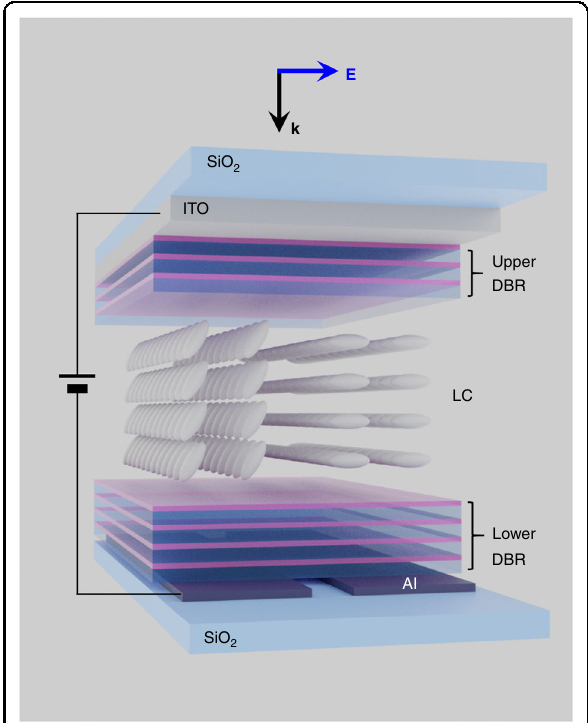
Fig. 1 Schematic view of the Fabry – Pérot cavity. It is composed of the LC as a refractive-index changing material sandwiched between the upper and lower distributed Bragg re fl ectors, allowing for the reduced cell gap and the corresponding small pixel size for the wide fi eld of view. The higher-order mode resonance in the cavity facilitates multi-spectral phase modulation in the visible regime